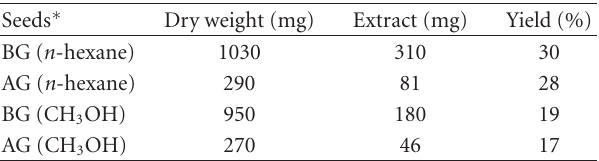
Table 1: Arithmetic mean of dry weight extracts and yields of V. surinamensis